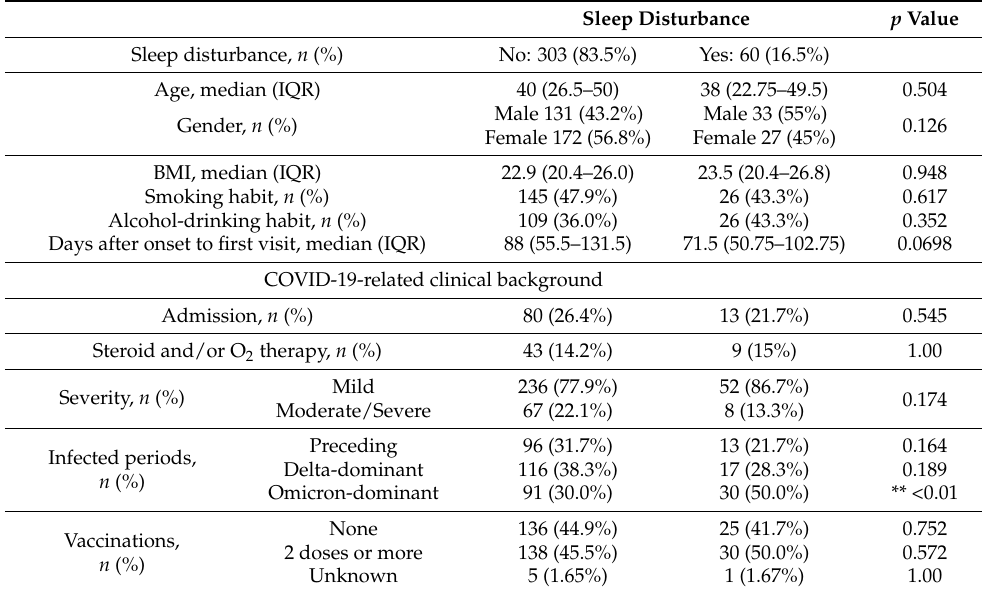
Table 1. Backgrounds of long COVID patients with, and those without, sleep